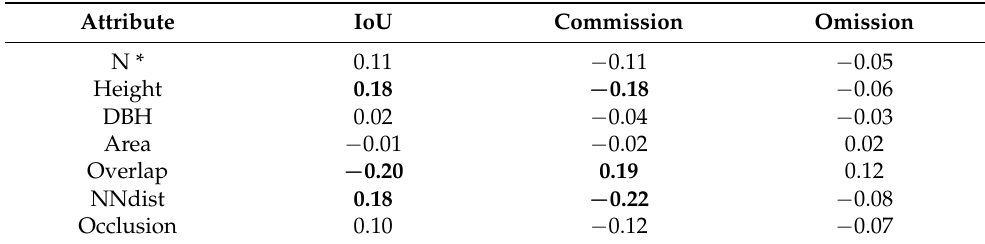
Table 4. Pearson’s r between individual-tree attribute and accuracy metrics. Attribute IoU Commission Omission N * 0.11 − 0.11 −